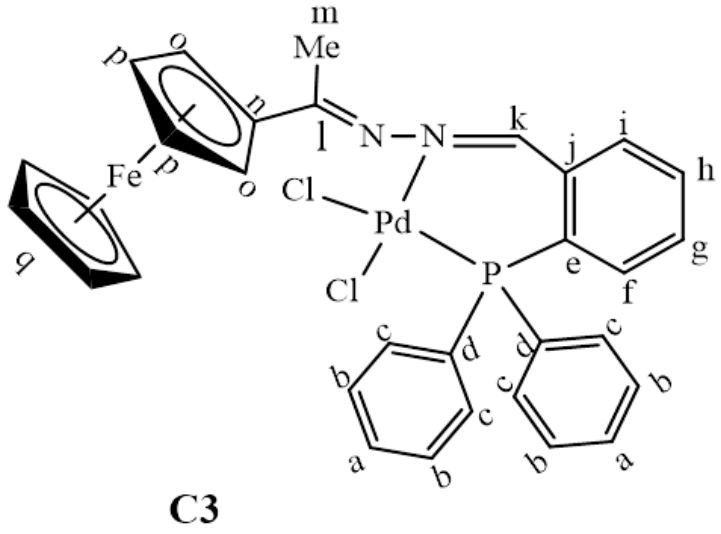
Figure 29. The chemical structure of C3 .